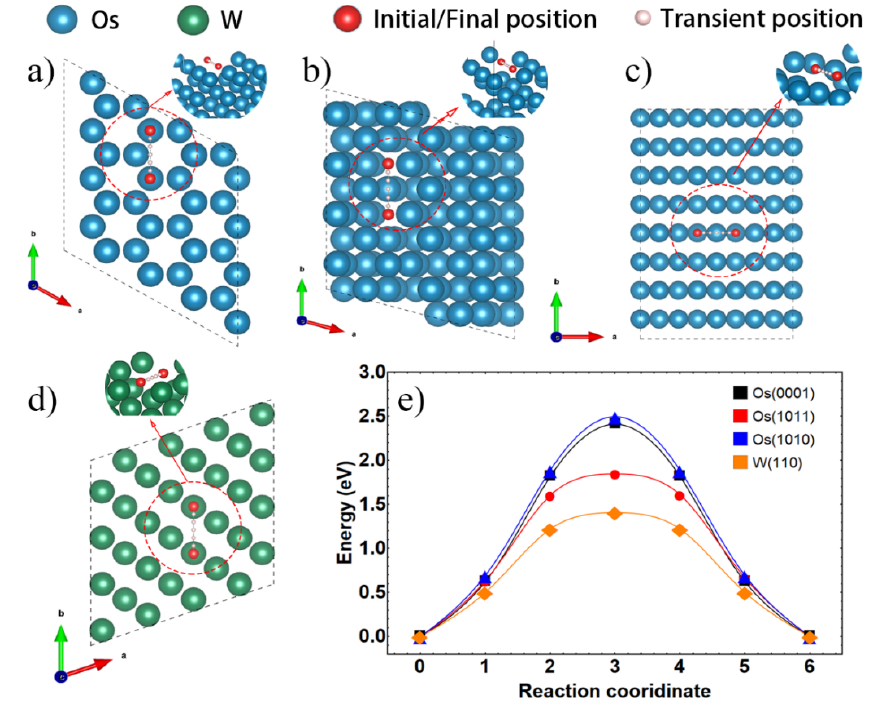
Figure 9. Models of surface vacancy migration of ( a – c ) Os on Os(0001)/(1010)/(1011) and ( d ) W on W(110), ( e ) the corresponding energy barriers.